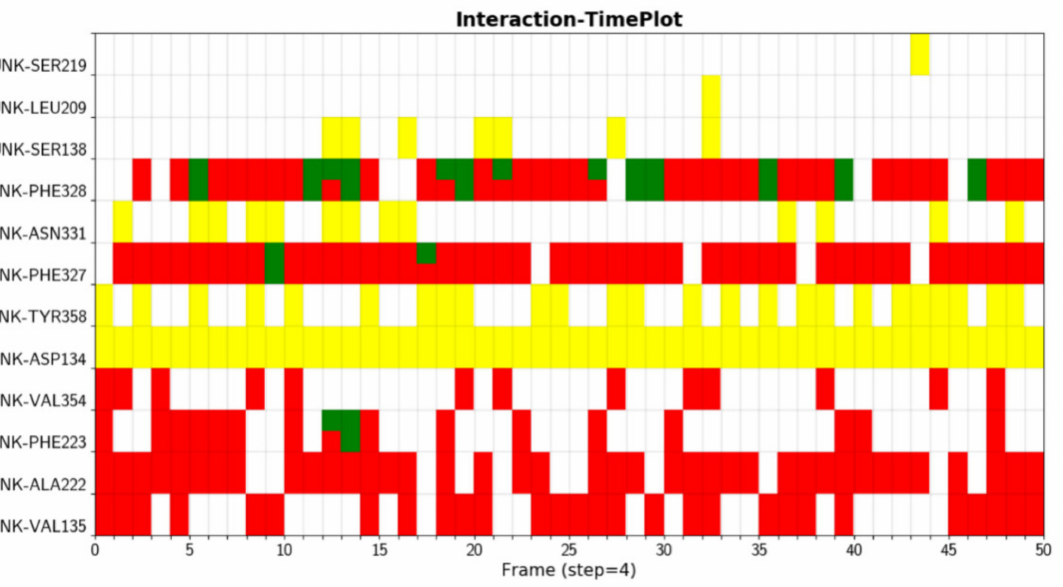
Figure 2. Interactions between protein (A2AR) and ligand (UNK) are displayed with respect to simulation time. The stability of protein, which is indicated by the RMSD (root-mean-square deviation) changes with respect to simulation time, is shown in Figure 3A. In this example, the protein RMSD values are all below 3.0 Å, suggesting that the conformation of the protein is stable during the simulation. The RSMF (root-mean-square fluctuation) plot can also be obtained with our webserver. RMSF can be used to describe the flexibility of a residue in the simulation. The larger the RMSF value is, the more flexible the residue is. As shown in Figure 3B, residues with RMSF value higher that 1.5 Å correspond to those in the flexible loop region. The RMSD of ligand is shown in Figure 3C, showing that the ligand does not change its orientations significantly during the